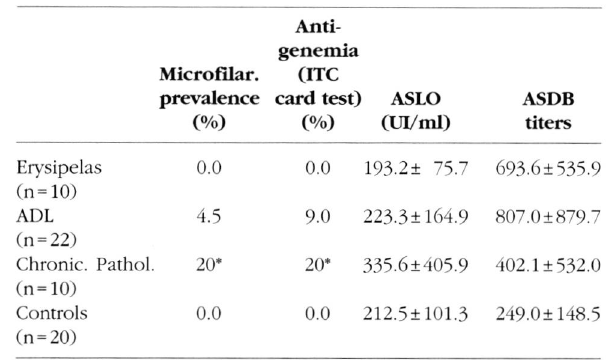
Table I. - Laboratory results of the detection of microfilaria, anti- genemia and antistreptococcal antibodies in erysipelas, Wuchereria bancrofti-assocuited adenolymphangitis (ADD or chronic pathology and healthy controls, from French Polynesia.